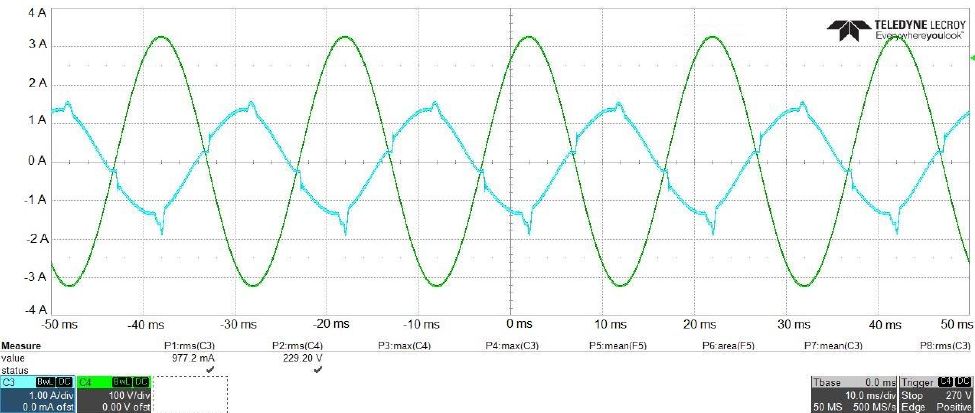
Figure 19. Experimental test setup of WPT system with electric kettle.